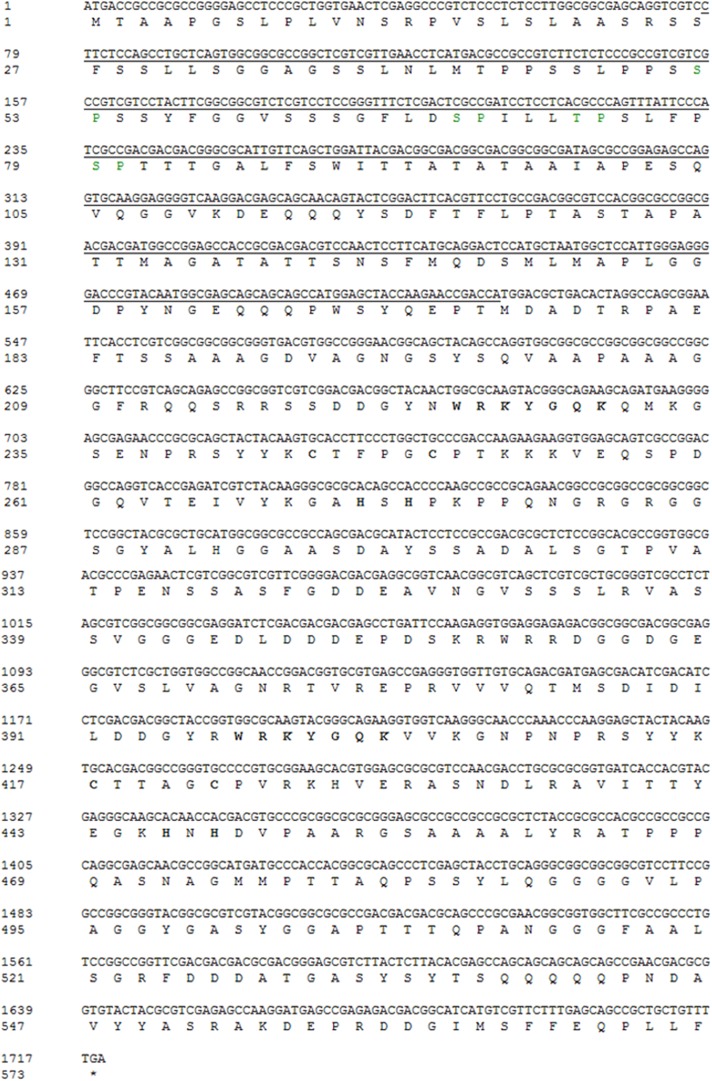
Nucleotide and amino acid sequence of OsWRKY70.SP cluster (green), WRKY domain and Zinc fingure (bold) were shown. The underline sequence was used for RNAi construction.